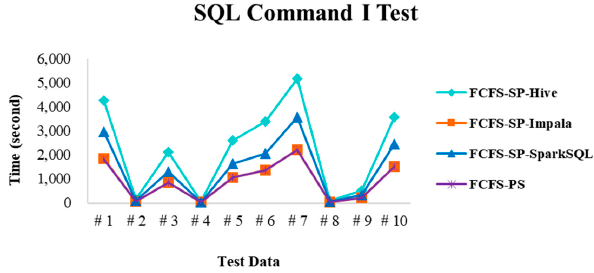
Figure 20. Execution time of SQL command I in test environment II.